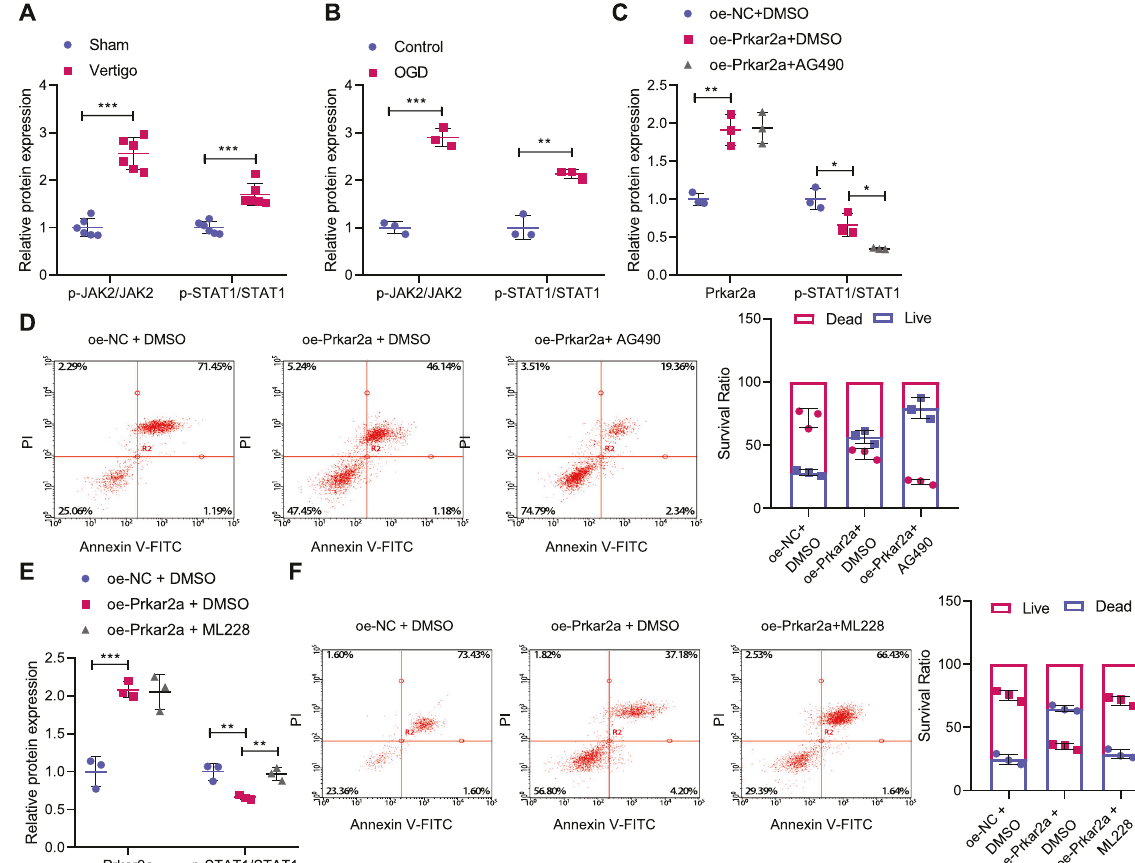
Fig. 5 Prkar2a suppressed neuronal apoptosis by inactivating the JAK2/STAT1 axis. A Western blot to determine the phosphorylation level of JAK2 and STAT1 in the MVN of mice with CI-induced vertigo and sham-operated mice; B Western blot to determine the phosphorylation level of JAK2 and STAT1 in OGD-exposed cells; C Western blot to determine the expression of Prkar2a and the phosphorylation level of STAT1 in OGD-exposed cells overexpressing Prkar2a with/without AG490 treatment; D fl ow cytometry to detect the apoptosis in OGD-exposed cells overexpressing Prkar2a with/without AG490 treatment; E Western blot to determine the expression of Prkar2a protein and the phosphorylation level of STAT1 in OGD-exposed cells overexpressing Prkar2a with/without ML228 treatment; F fl ow cytometry to detect the apoptotic rate in OGD-exposed cells overexpressing Prkar2a with/without ML228 treatment. * p < 0.05, ** p < 0.01, *** p < 0.001. Independent sample t test was applied for the comparison between two groups, and one-way ANOVA with Tukey ’ s post hoc test was